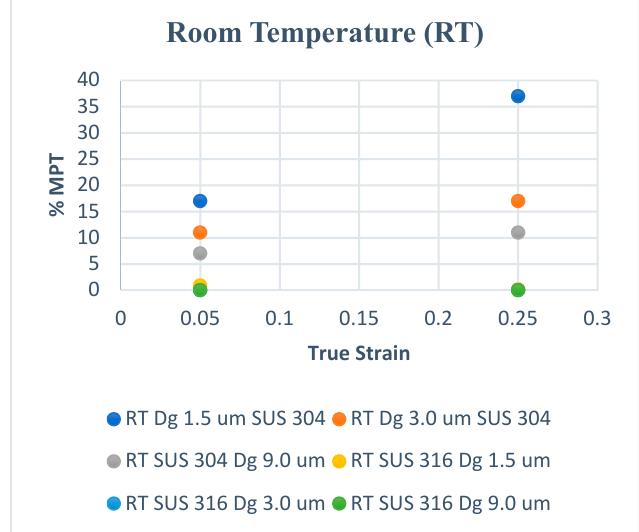
Figure 2. MPT at room temperature.